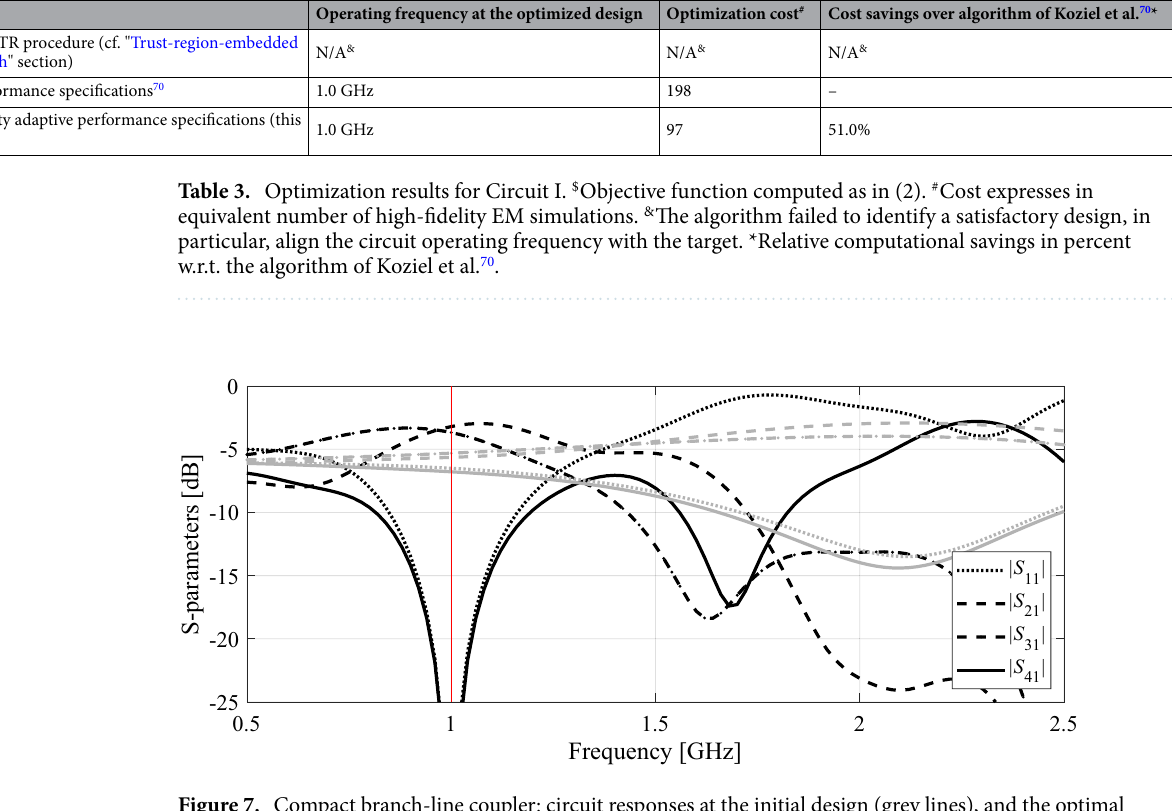
Figure 7. Compact branch-line coupler: circuit responses at the initial design (grey lines), and the optimal design rendered by the introduced framework with design specification adaptation and variable-fidelity models (black lines). Vertical line marks target operating frequency.